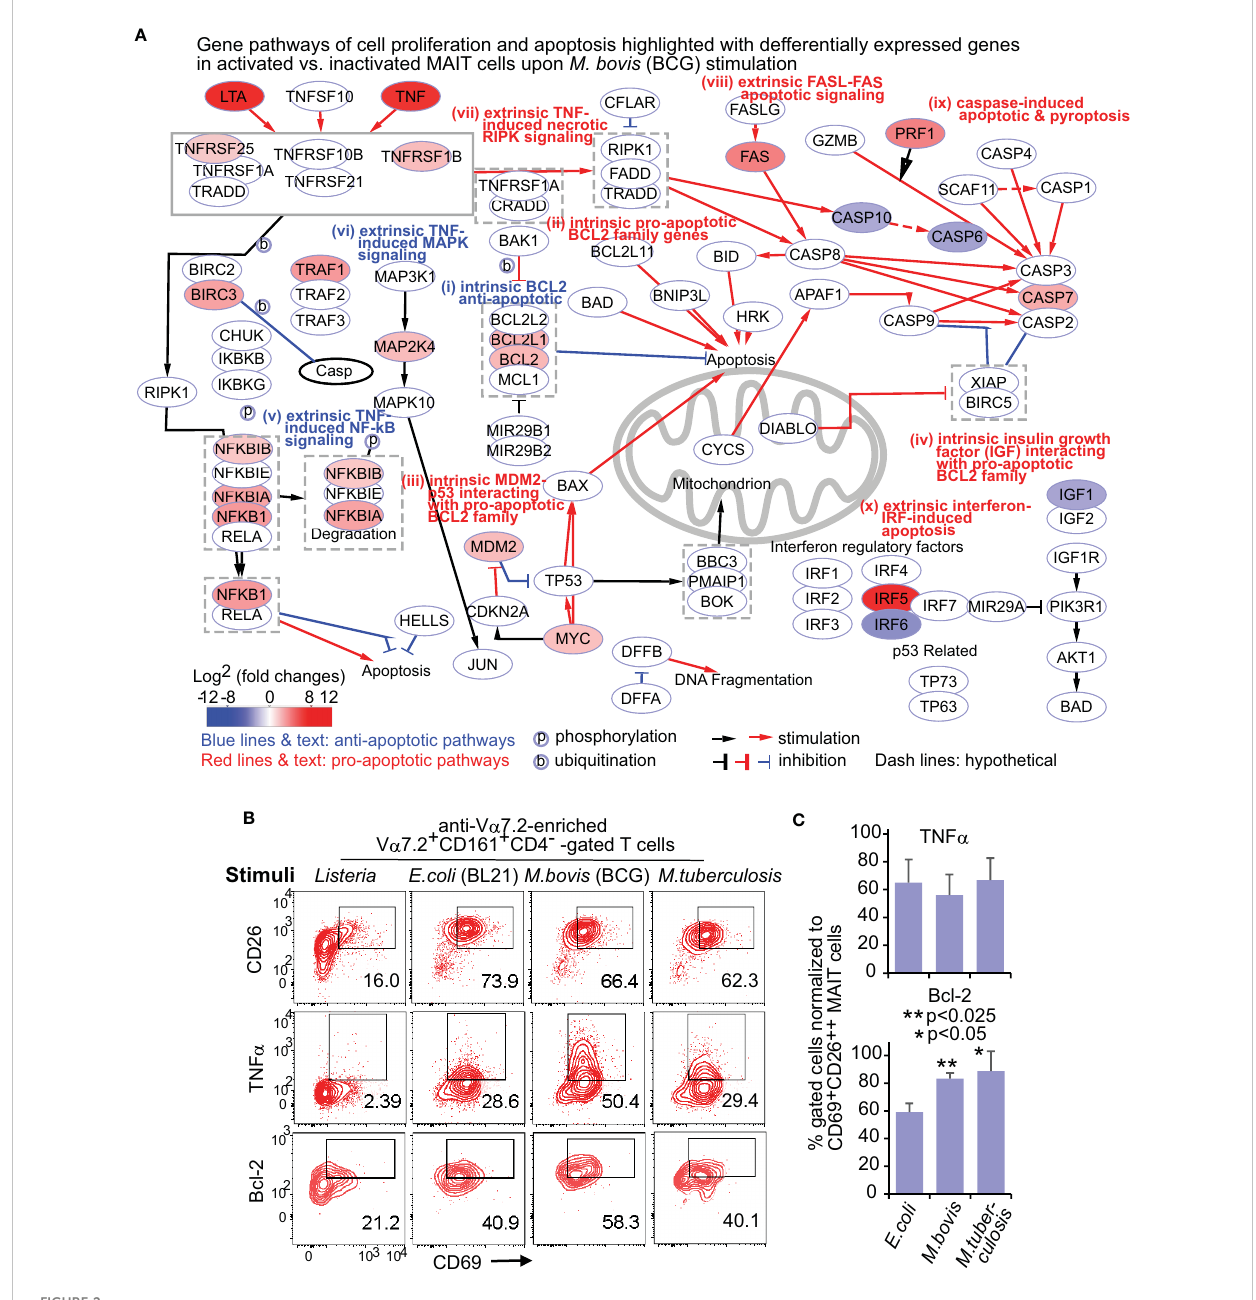
FIGURE 2 BCG stimulate differential gene and protein expression of MAIT cells in proliferation and apoptosis pathways. DEGs between activated (CD69 + CD26 + + ) subsets versus inactivated (CD69 +/- CD26 +/- ) subsets of CD8 + MAIT cells upon BCG stimulation were annotated in pathways of cell proliferation and apoptosis (A) . Protein expression of key cytokine TNF a and key regulatory protein Bcl-2 were con fi rmed with the percentage of CD69 + TNF a + , and CD69 + Bcl-2 + subsets in comparison to the CD69 + CD26 ++ subset of CD8 + MAIT cells detected by fl ow cytometry (B) . The gating strategy is shown in Figure S1. The percentage of CD69 + TNF a + or CD69 + Bcl-2 + subsets of CD8 + MAIT cells was normalized with the percentage of activated CD69 + CD26 ++ subsets of CD8 + MAIT cells. Plots show the means of these normalized percentages and standard errors from multiple donors. A pairwise t-test was used to determine the signi fi cance of differences between BCG and E. coli stimulations (C)